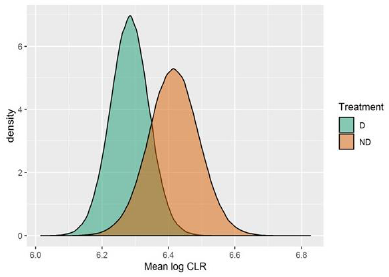
Fig. 7. Estimate the difference in mean log AUC0-12 between Metformin + Daclatasvir (D) and Metformin only (ND) groups